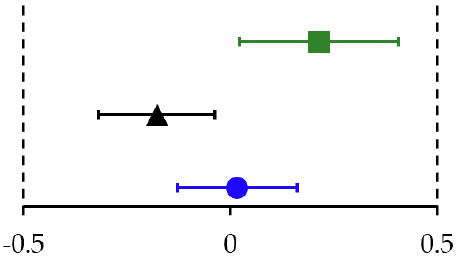
Figure 3. Estimated mean (90% CI) of change in weight-for-age z -scores from baseline to 4 months for pHF1.8 (blue), pHF2.0 (black) and pHF2.27 (green). Assessment of equivalence with the WHO Child Growth Standards, applying predefined margins of ± 0.5 SD.